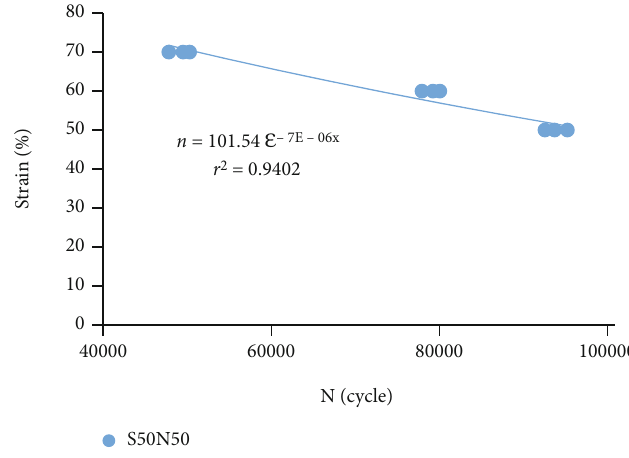
Figure 4: Fitted curve error in the strain-life diagram of S50N50